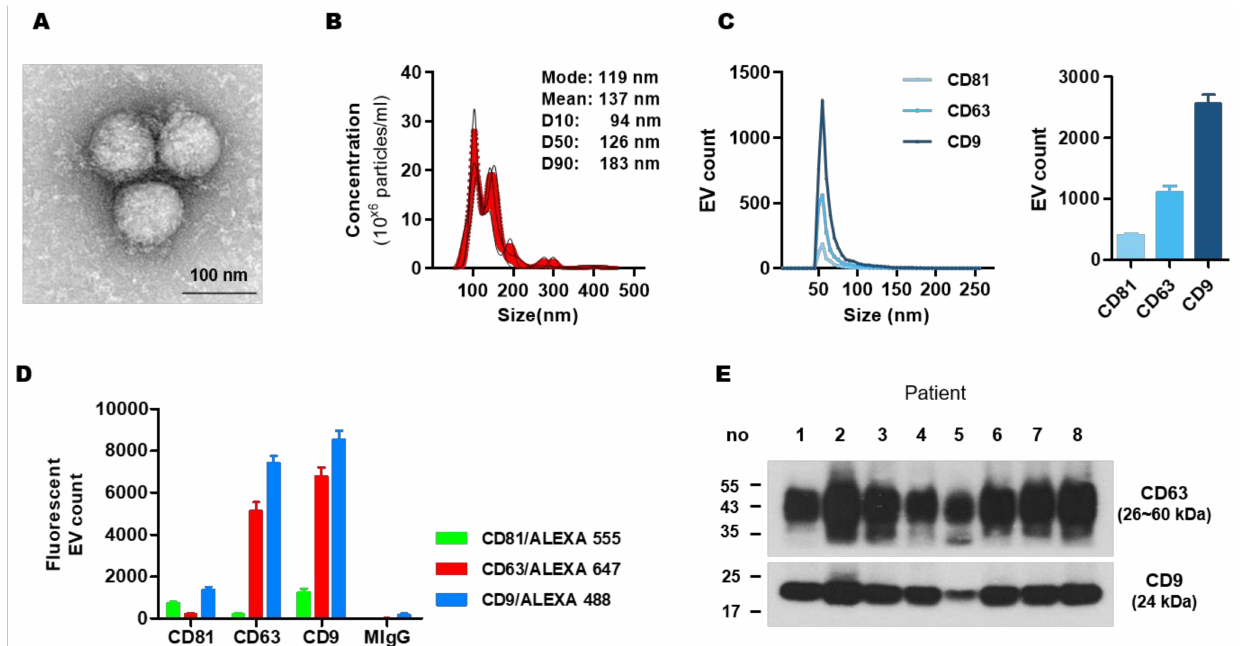
Figure 1. Characterization of exosomes in BC patients. ( A ) Transmission electron microscopic (TEM) observation of exosomes isolated from patients. Scale bar = 100 nm. ( B ) Nanoparticle tracking analysis. The calculated size distribution is depicted as mean (black line) with standard error (red shading). ( C ) ExoView assay was done to measure particle distribution and the number of CD81, CD63, and CD9-positive exosomes. ( D ) Co-expression of exosome markers was measured by probing captured EVs with the indicated secondary fluorescence-labeled antibody. ( E ) Western blot for exosomal protein markers CD63 and CD9 in eight different patients. The uncropped blots of ( E ) were shown in Figure